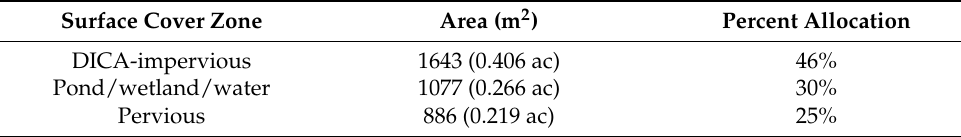
Table 10. Allocation of the surface cover zone and the corresponding